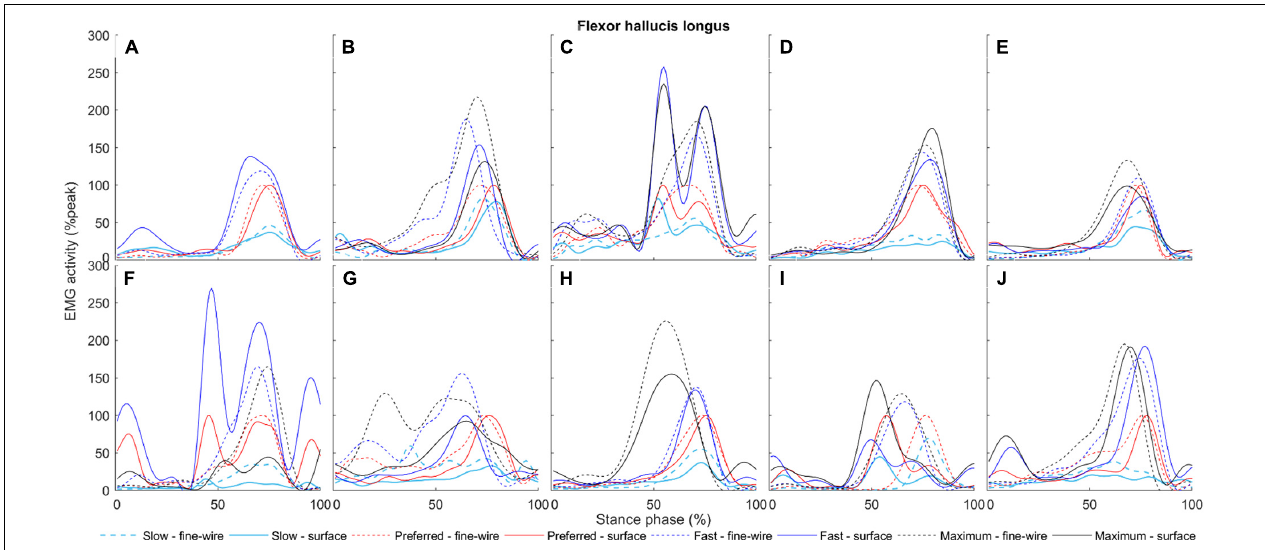
FIGURE 7 | Flexor hallucis longus surface (solid) and intramuscular (dashed) electromyography (EMG) activity at slow, preferred, fast, and maximum walking speeds (1.01 ± 0.13, 1.43 ± 0.19, 1.84 ± 0.23, and 2.20 ± 0.38 m s − 1 , respectively) in the stance phase for each individual ( A–J , respectively). The amplitudes of smoothed and time-normalised EMG curves were normalised to peak activity in preferred speed walking (%peak). Each curve represents the average of all steps (number of steps included in the analysis were 14 ± 3, 12 ± 3, 11 ± 2, and 9 ± 1, median ± interquartile range, at slow, preferred, fast, and maximum walking speeds, respectively) at a given walking speed.